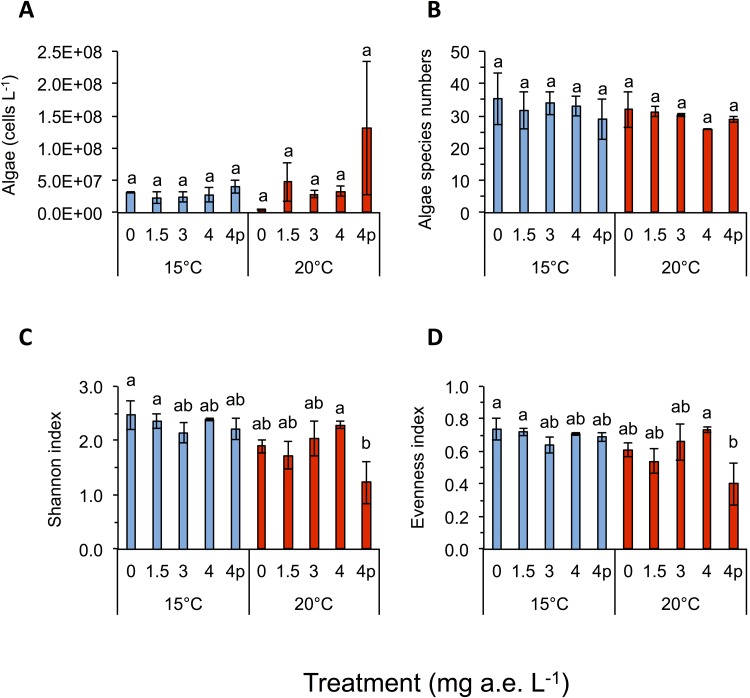
(A) Algae abundance, (B) number of species (C) diversity depicted using Shannon- and (D) evenness-index in response to different herbicide treatments (mg a.e. L−1) at 15 or 20 °C.Mean ± SD, 24 days after experiment start, n = 3. Means with different letters are significantly different (Tukey HSD, P < 0.05).